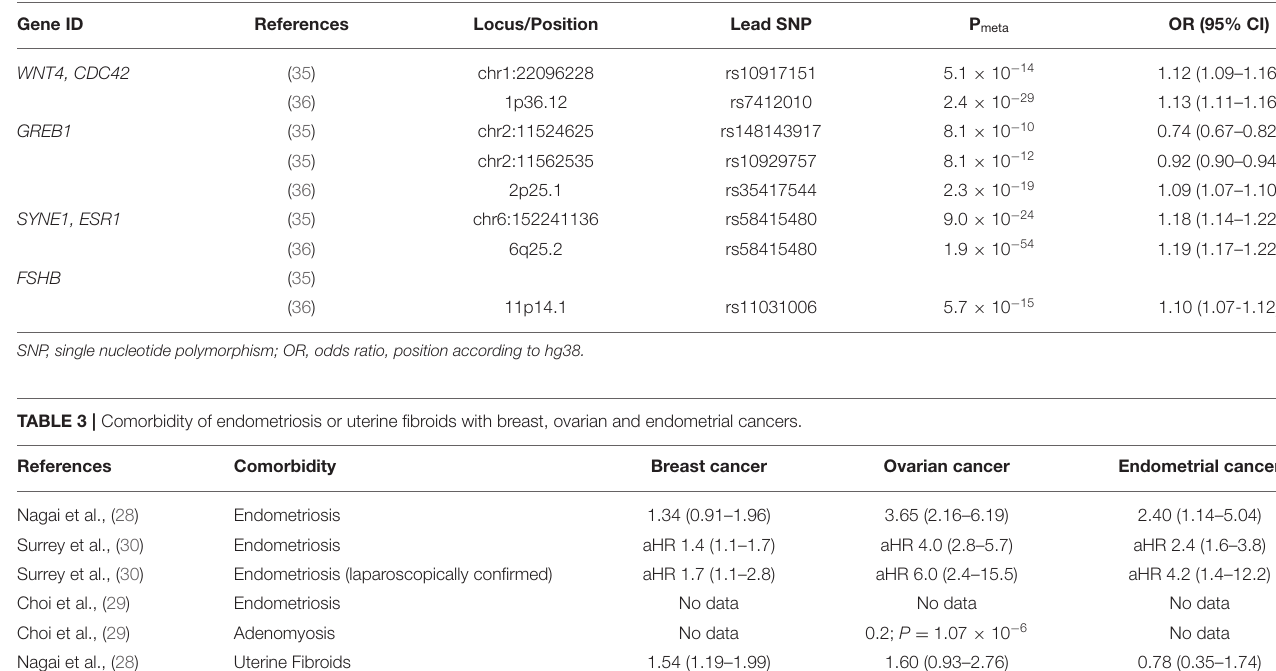
TABLE 2 | Risk alleles for the development of uterine fibroids previously associated with endometriosis.